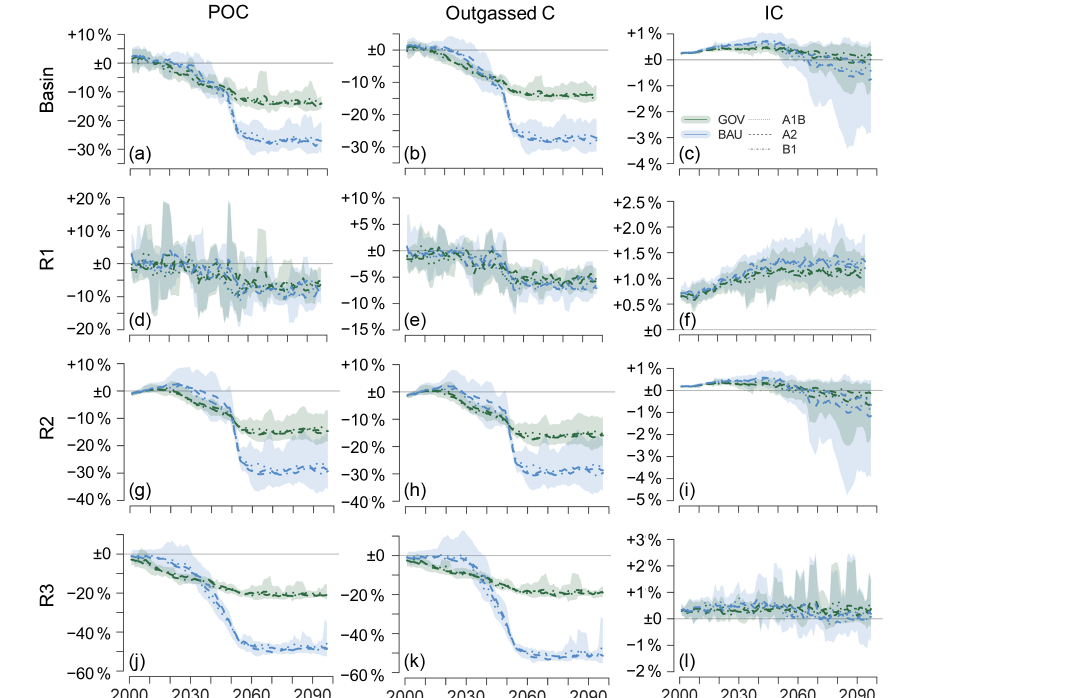
Figure 6. Temporal change in riverine organic carbon due to land use change only. Change of annual sum of carbon in the deforestation scenario (GOV or BAU) compared to the NatVeg scenario for the whole basin (a–c) and the three subregions (R1–R3; d–l ) as 5-year mean for GOV (green) and BAU (blue), representing E Defor . The shaded areas indicate the full range of values of all five climate models. Bold lines represent the 5-year mean of the five climate